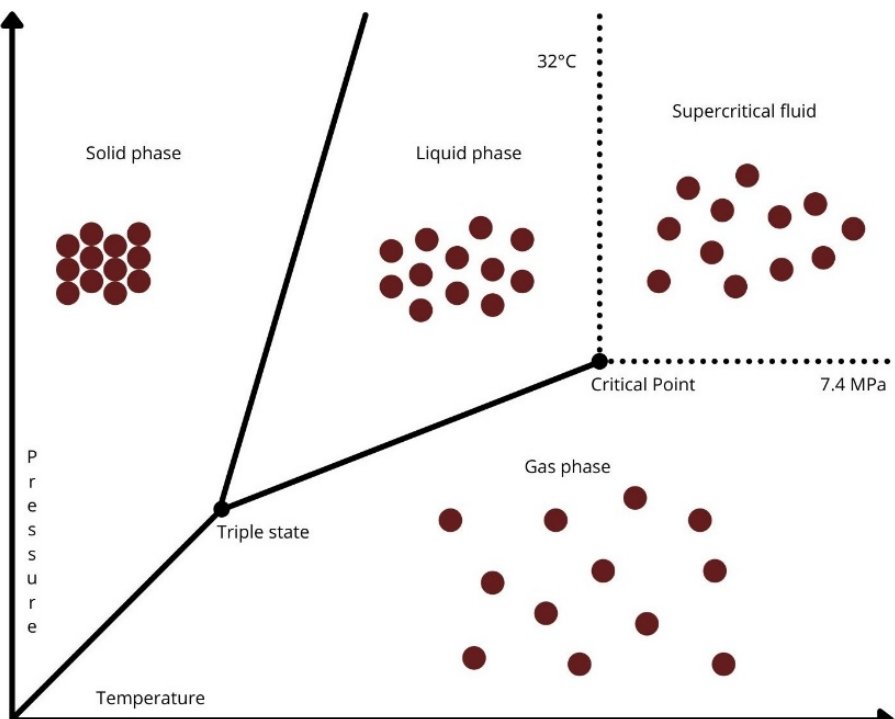
Figure 1. Phase diagram of carbon dioxide.